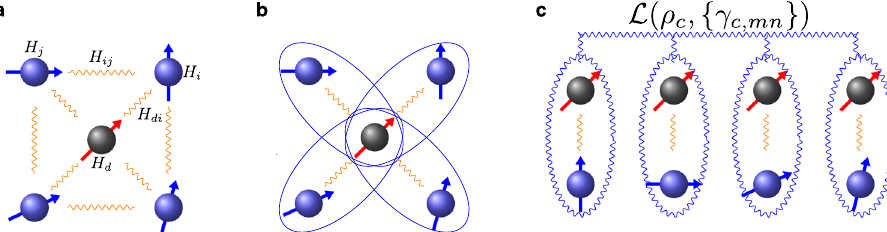
Fig. 1 Illustration of the approximations used in the calculation of dipolar spin relaxation. a Many-spin system. b Cluster approximation and central spin approximation of the many-spin system. c Coupled Lindbladian master equation to retain relevant properties of the modeled